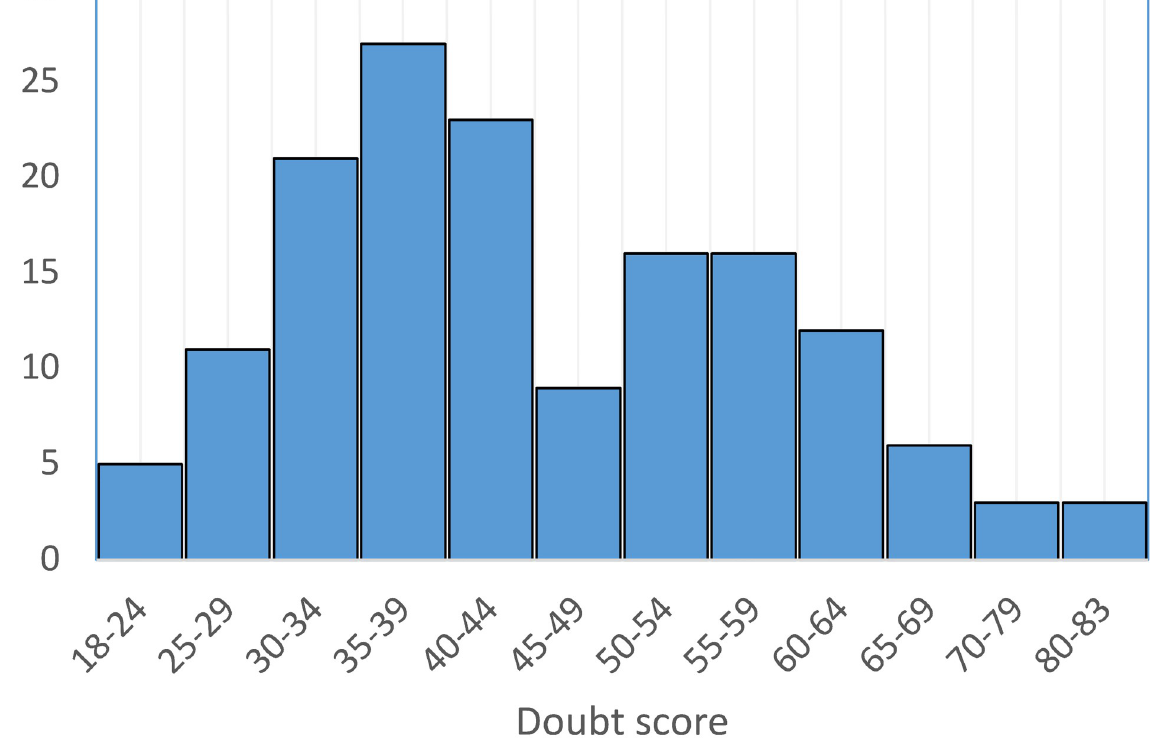
Fig 1. Distribution of doubt scores in internet participants (N =